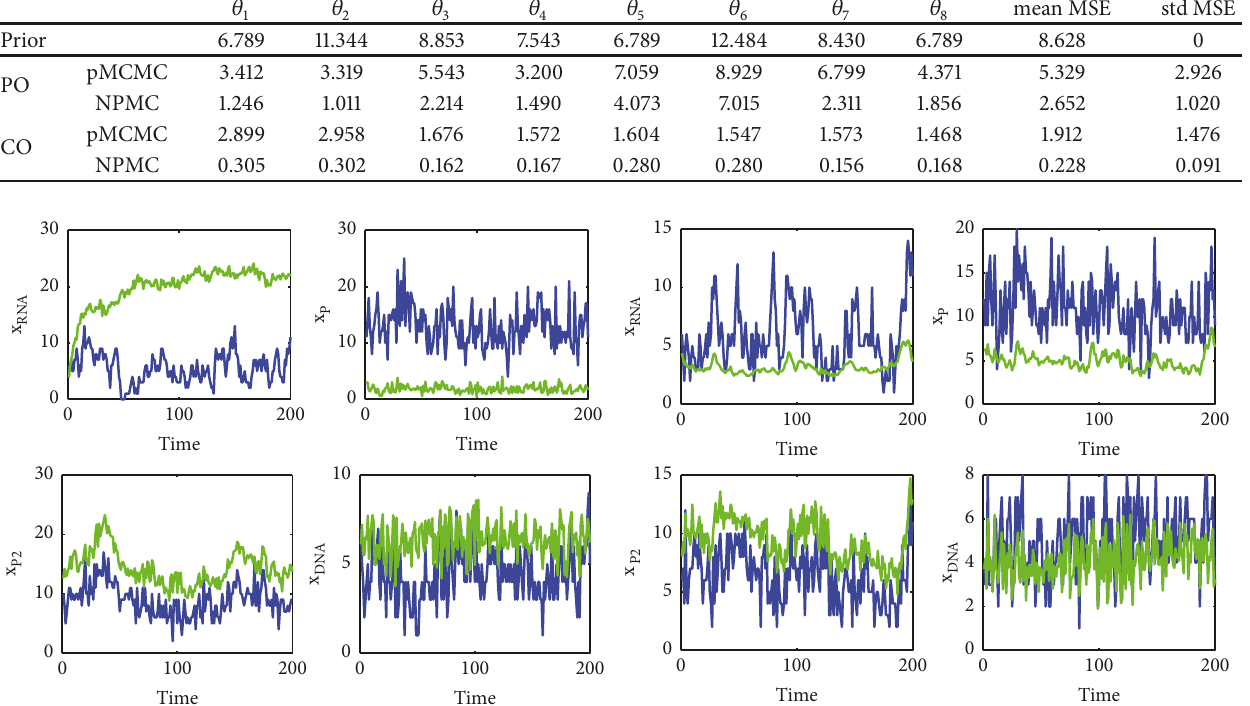
Table 2: Final MSE for the parameters 𝜃 𝑘 , 𝑘 = 1, .. ., 𝐾 in the CO and PO experiments, averaged over the simulation runs. The last two columns correspond to the mean and standard deviation (std) values of the global MSE (averaged over the parameters). The prior values are included for comparison.